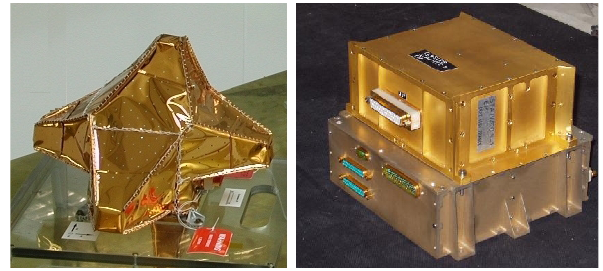
Fig. 1. Main elements of the STAFF-DWP experiment, at test. On the left: picture of the three-axis search coil magnetometer with its thermal blanket. On the right, the electronic box: on the bottom is the DWP box, on top of which is the magnetic waveform unit